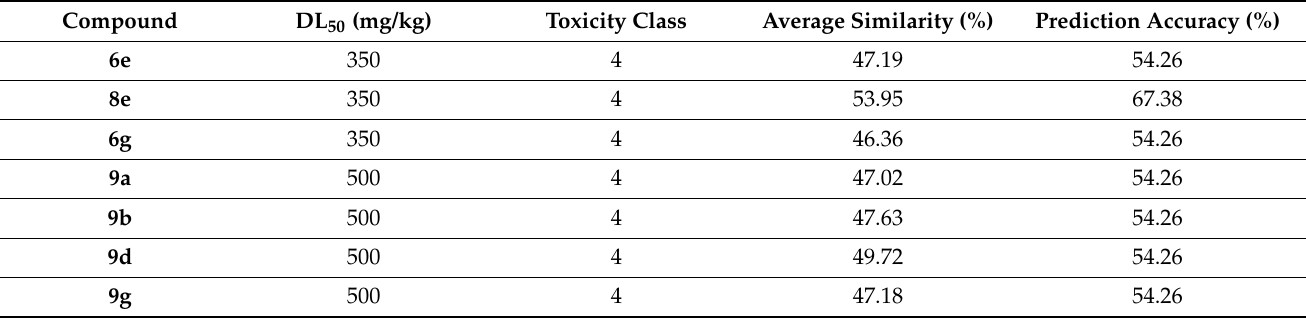
Table 4. Acute toxicity results obtained from ProTox-II web